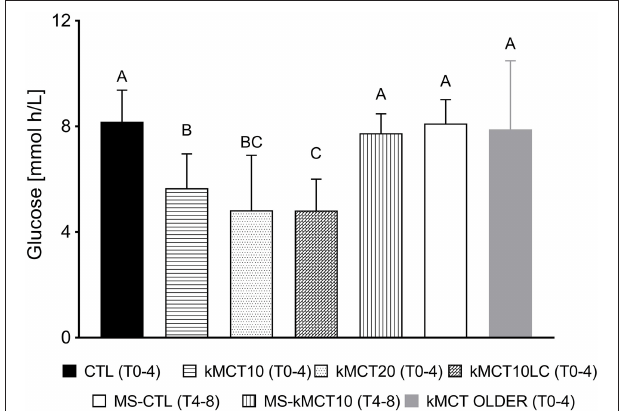
FIGURE 3 | Area-under-the-curve (mmoLh/L) for the post-prandial plasma glucose response at T0-T4 without consuming kMCT (CTL), after 10g of kMCT (kMCT10), with no meal at T0 but a meal at T4 without kMCT (MS-CTL) and no meal at T0 but a meal at T4 with 10g of kMCT (MS-kMCT10). The time period of the area-under-the-curve for each bar is shown in brackets. Values are presented as mean ± SD ( n = 6–10). Means without a common letter differ significantly (A < B); P < 0.05.